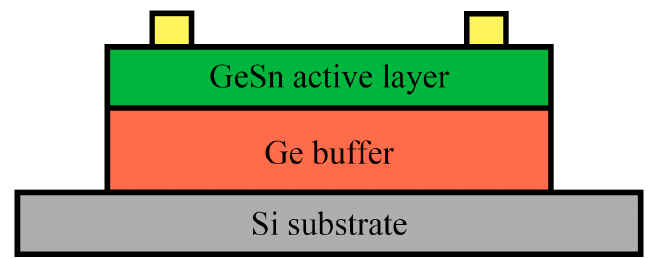
Figure 1. Cross-section view of the one-layer GeSn on Ge photoconductor.